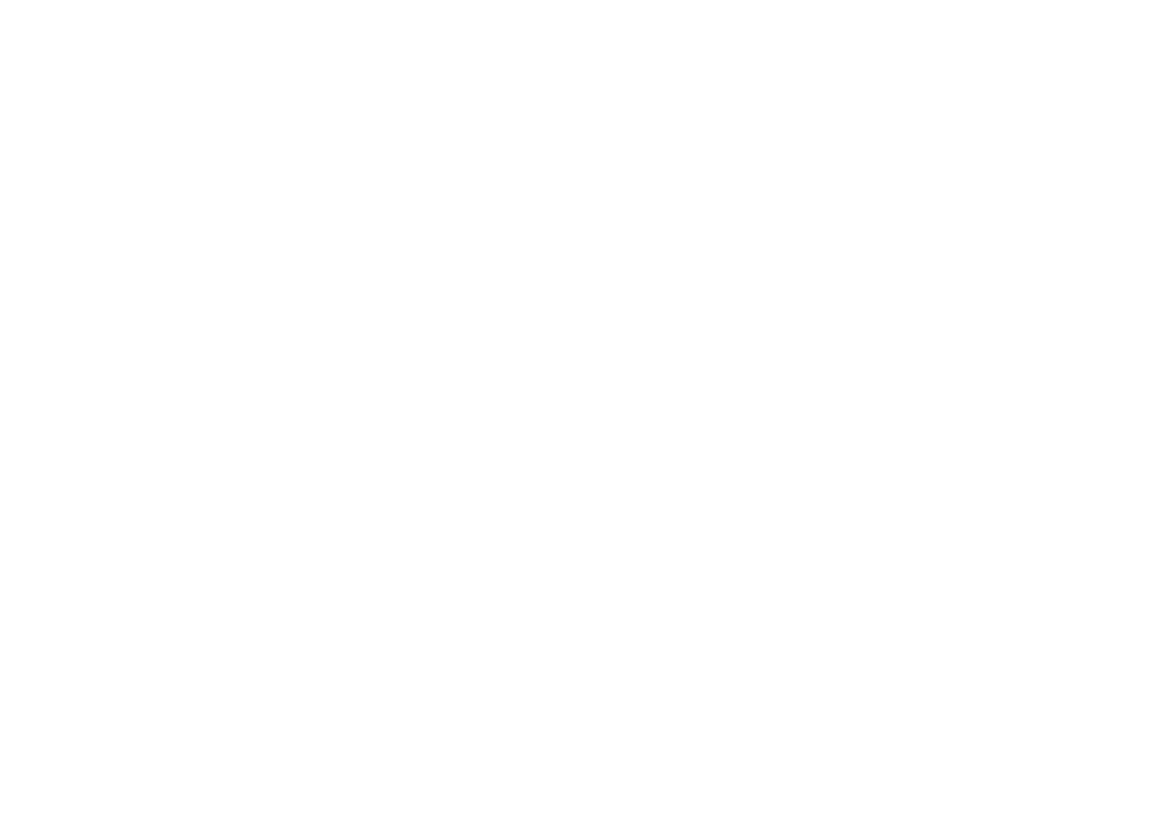
Figure 10. Root mean square fluctuation (RMSF) plots for docked complexes of AQ-M pro